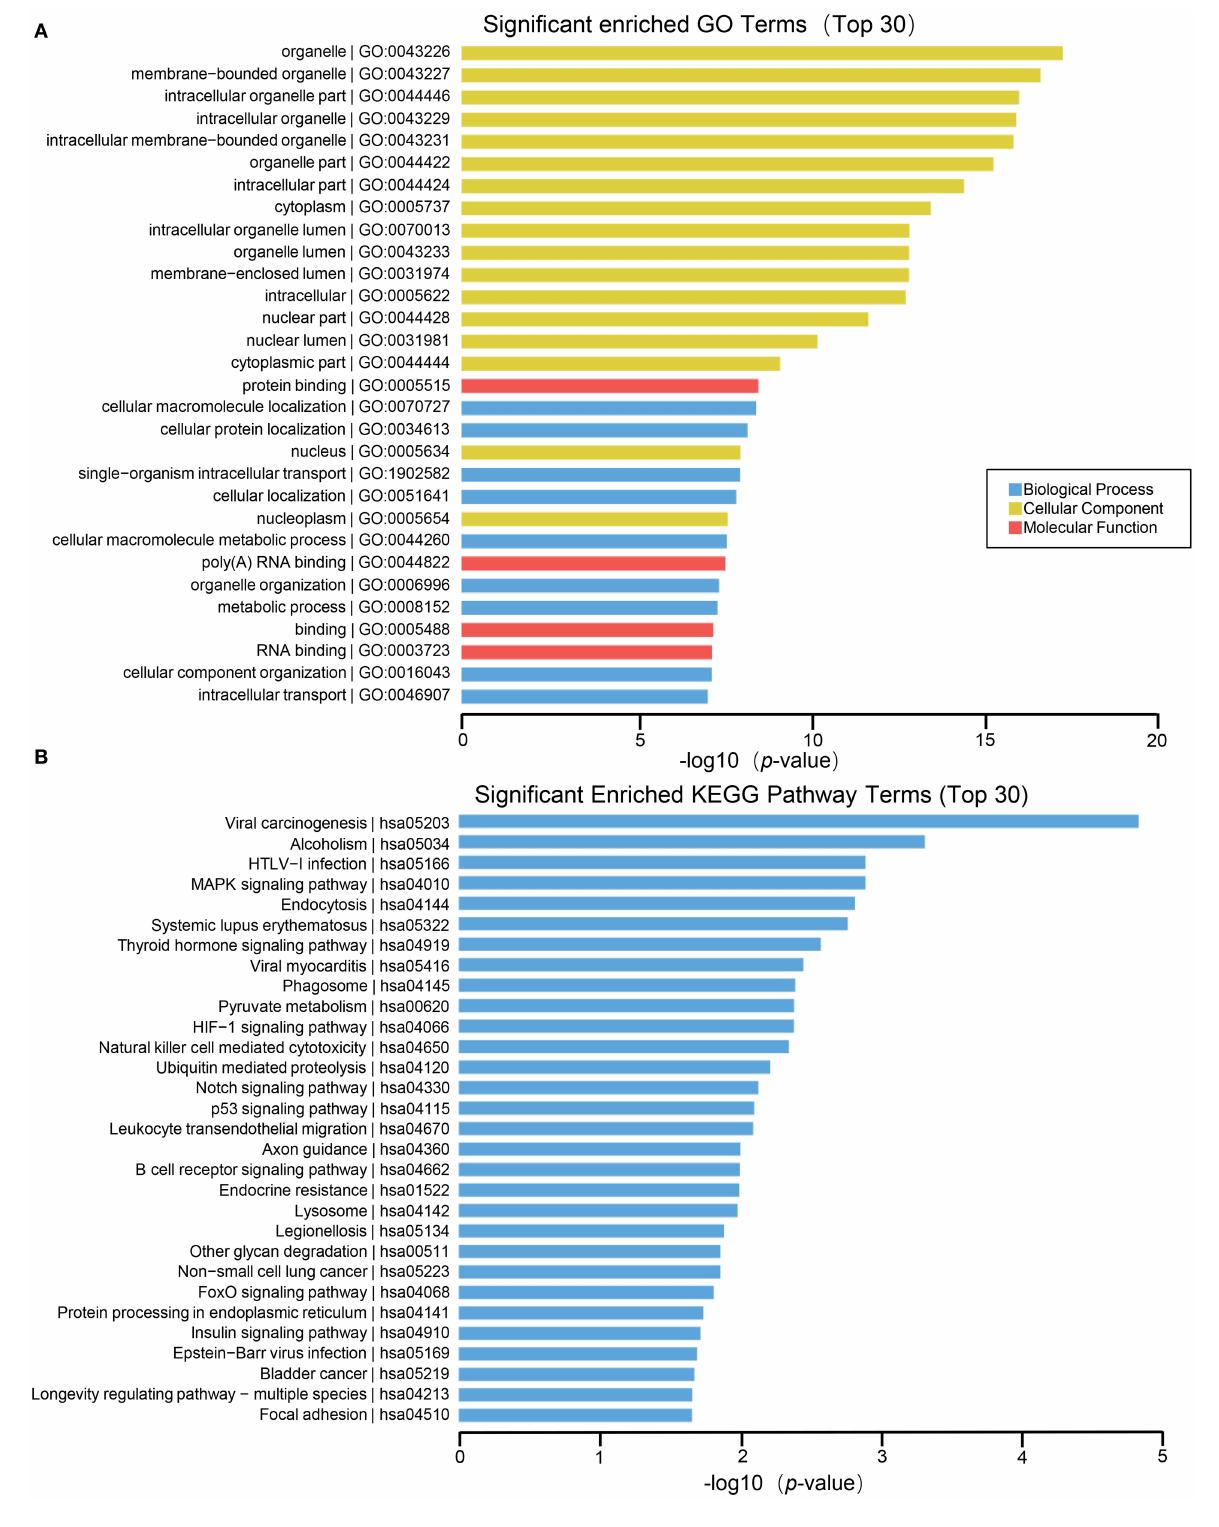
Frontiers in Neuroscience | www.frontiersin.org